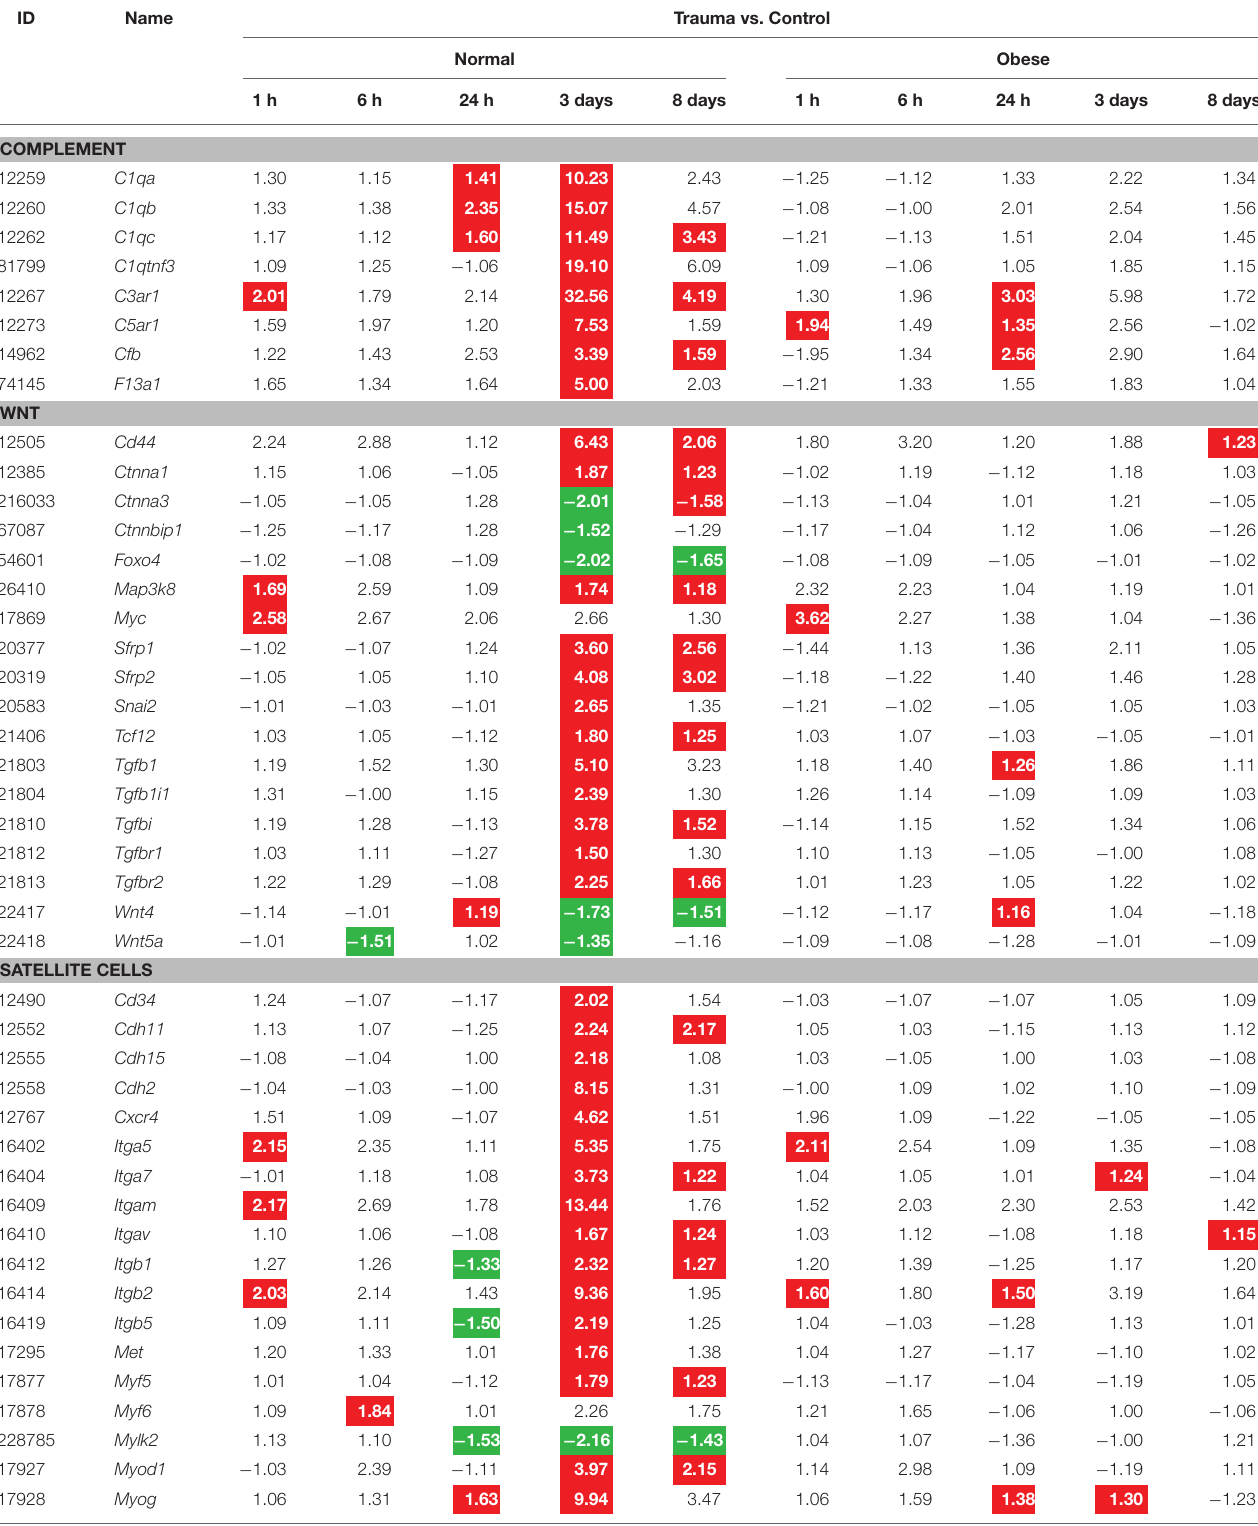
TABLE 5 | Gene expression levels in fold change values determined by microarray analysis for complement, Wnt and satellite